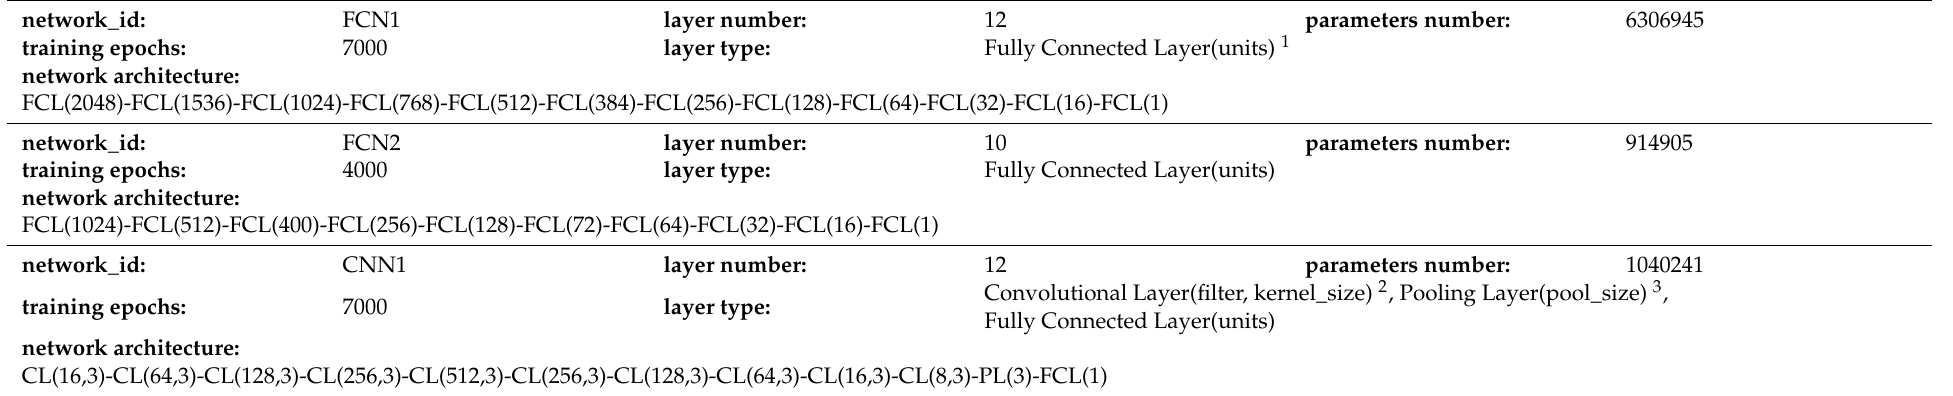
Table A2. Detailed architecture of 13 different deep neural